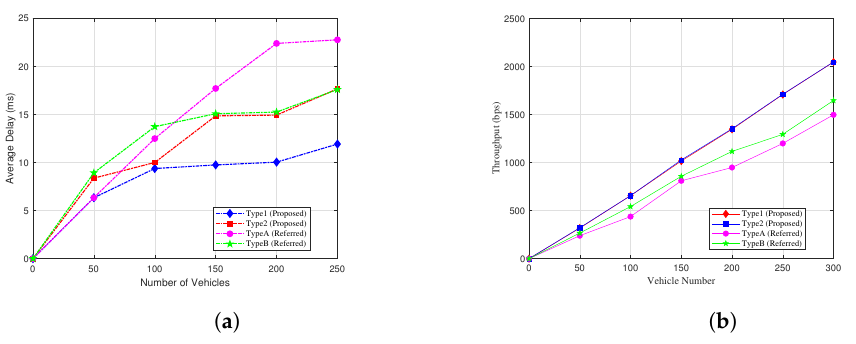
Figure 5. Proposed algorithms delay and throuput performance evaluation. ( a ) Information broad- casting delay. ( b ) System throughput vs. the number of